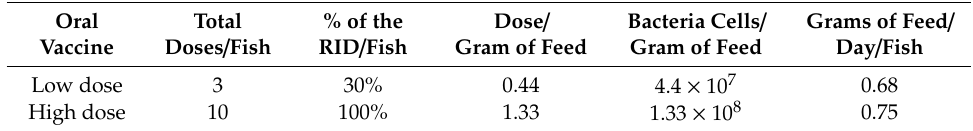
Table 1. Characteristics of the experimental oral vaccines prepared with alginate encapsulated Piscirickettsia salmonis antigens in high dose and low dose.